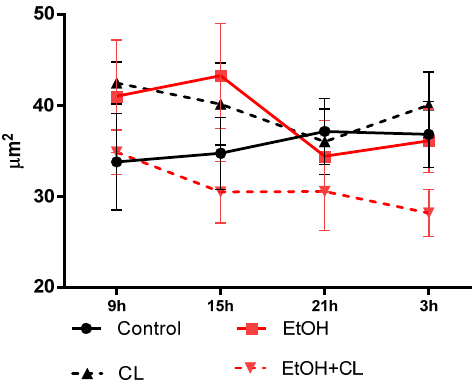
Figure 13. Daily dynamics of hepatocyte nuclei area of rats. Table 2. Results of the cosinor analysis of the daily dynamics of the micromorphometric parameters of hepatocytes of